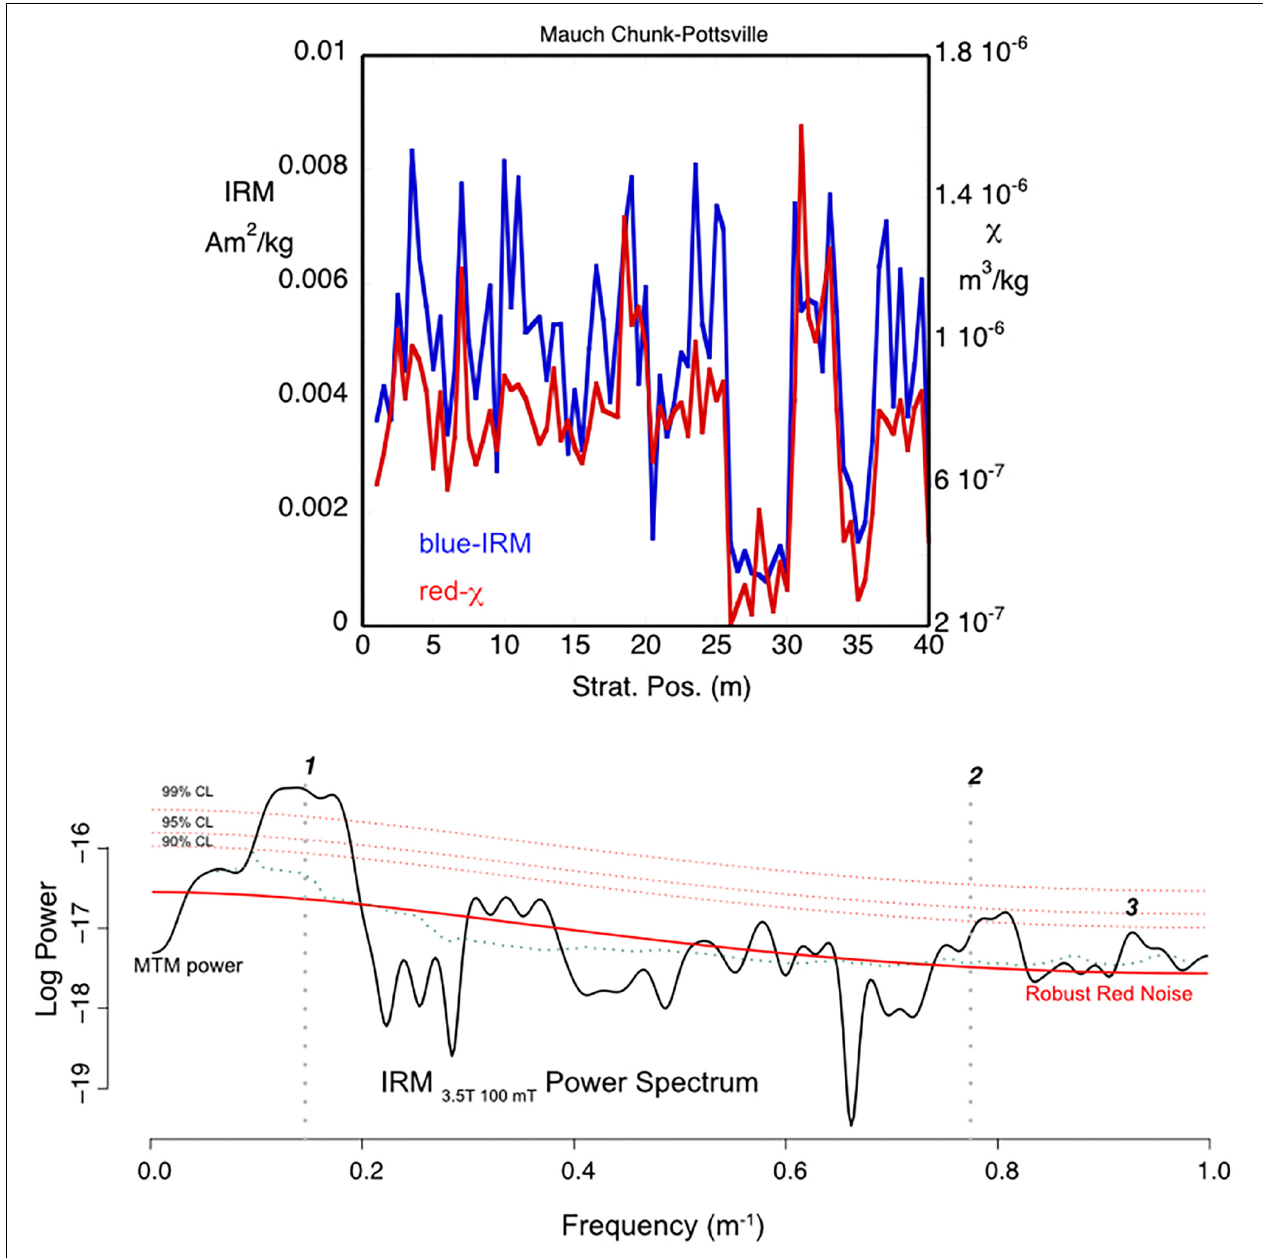
FIGURE 2 | (Top) Time series of IRM acquired in a 3.5 T field and then alternating field demagnetized at 100 mT (blue curve) and magnetic susceptibility (red curve) for the 40 m of Pottsville section measured in 2012 by the graduate class at Lehigh University. Both curves show both long period and short period oscillations in phase with each other. The amplitudes of the variation are greater for the IRM. (Bottom) The MTM (Thomson, 1982) power spectrum for the IRM calculated by Astrochron indicates two significant peaks, one at 6.8 m stratigraphic thickness (labeled 1) and 1.3 m stratigraphic thickness (labeled 2). A third significant peak ( ∼ 1.1 m-labeled 3) is selected by Astrochron when the confidence level selection criterion is dropped from 0.9 to 0.85.